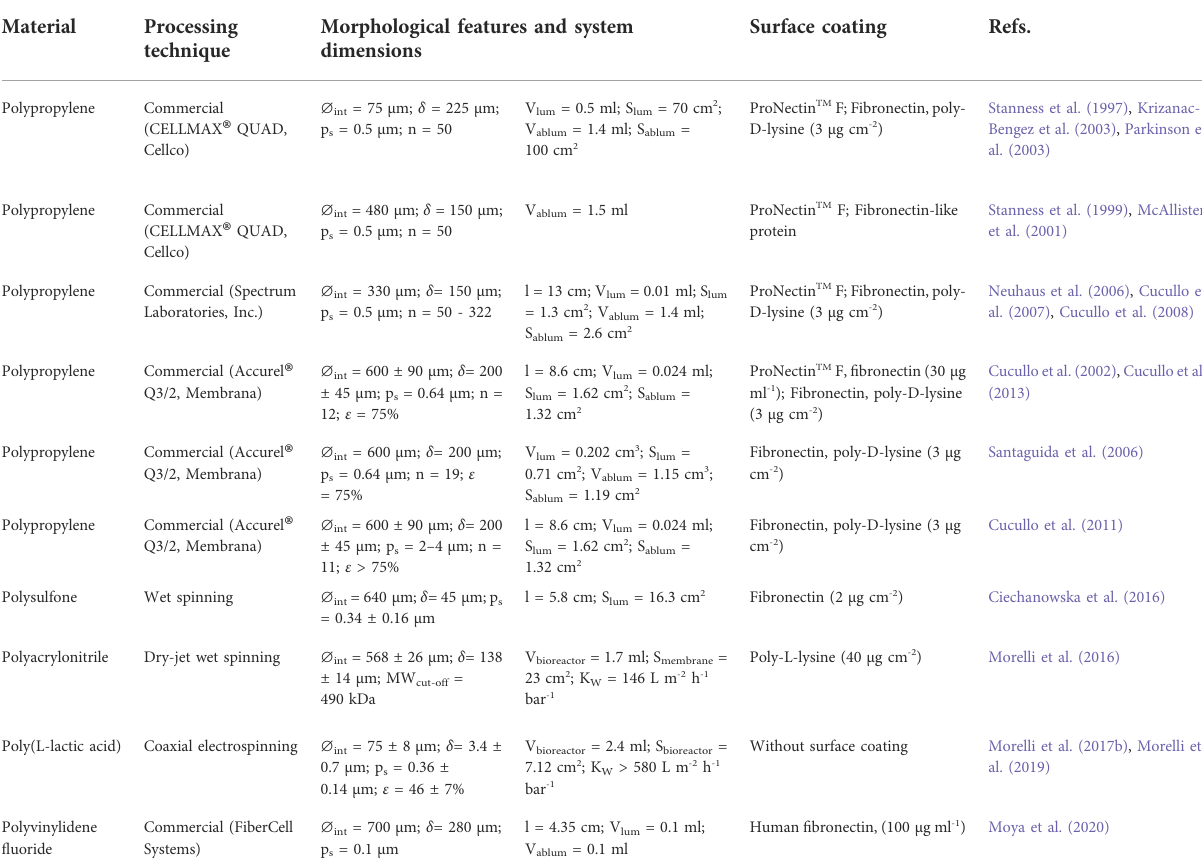
TABLE 1 Overview and characteristics of the hollow fi ber membranes used in DIV-BBB fl ow-based models. Material Processing Morphological features and system technique